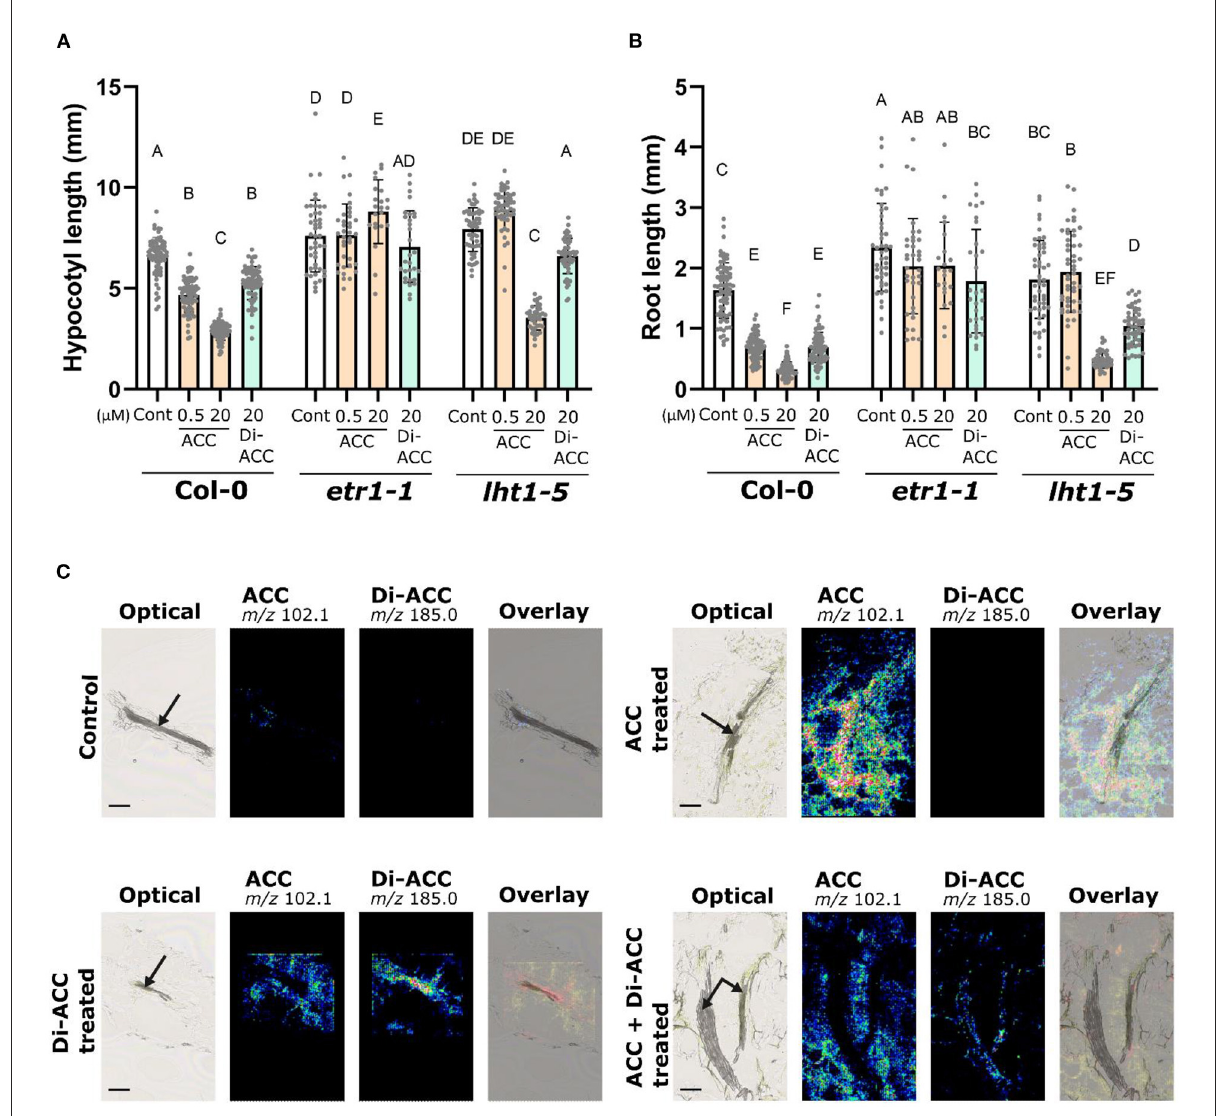
FIGURE2 ACC dimer induces triple response phenotype via ethylene signaling and shows an LHT1-dependend mobility. (A) Hypocotyl and (B) root length of 4-day-old dark-grown Col-0 wild-type, etr1-1 and lht1-5 seedlings after growth with ACC or di-ACC ( n ≥ 22). (C) Nano-PALDI MS images of hypocotyl sections of plants treated overnight with 2 µ M ACC, di-ACC, or both. Panels show optical images, ACC signal ( m/z 102.1), di-ACC signal ( m/z 185.0) and an overlay. The overlay for control and ACC treated plants includes the optical image and the ACC signal, and for di-ACC and ACC + di-ACC treated plants includes the optical image, ACC and di-ACC signals (yellow for ACC and red for di-ACC). The vascular tissue is indicated with